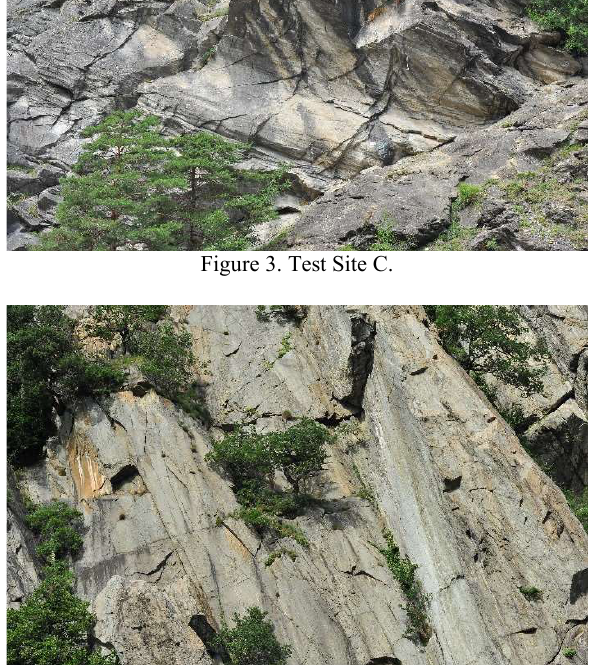
Figure 4. Test Site